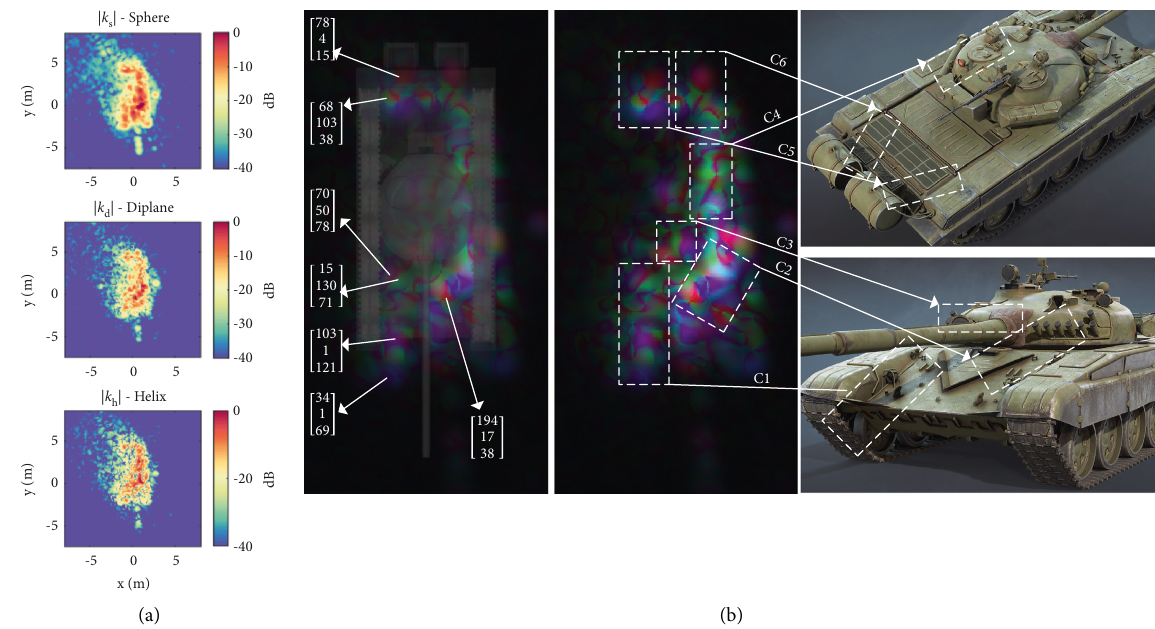
Figure 7: Krogager decomposition results. The three scattering components are displayed individually in (a) and as a composite RGB image in (b) with R � | k d | , G � | k h | , and B � | k s | image channels. Sample [ R ; G ; B ] values and scattering regions C1 to C6 are also depicted together with a 3D CAD model used for illustration